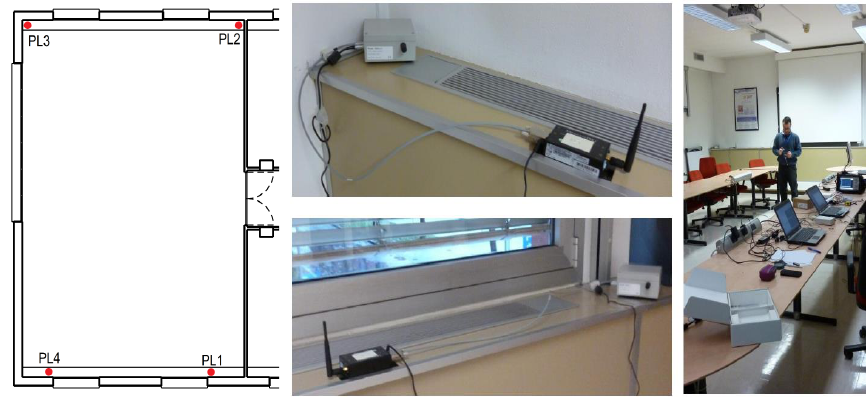
Figure 4. Deep indoor scenario: tests have been conducted in a large meeting room (about 10 × 7 m).